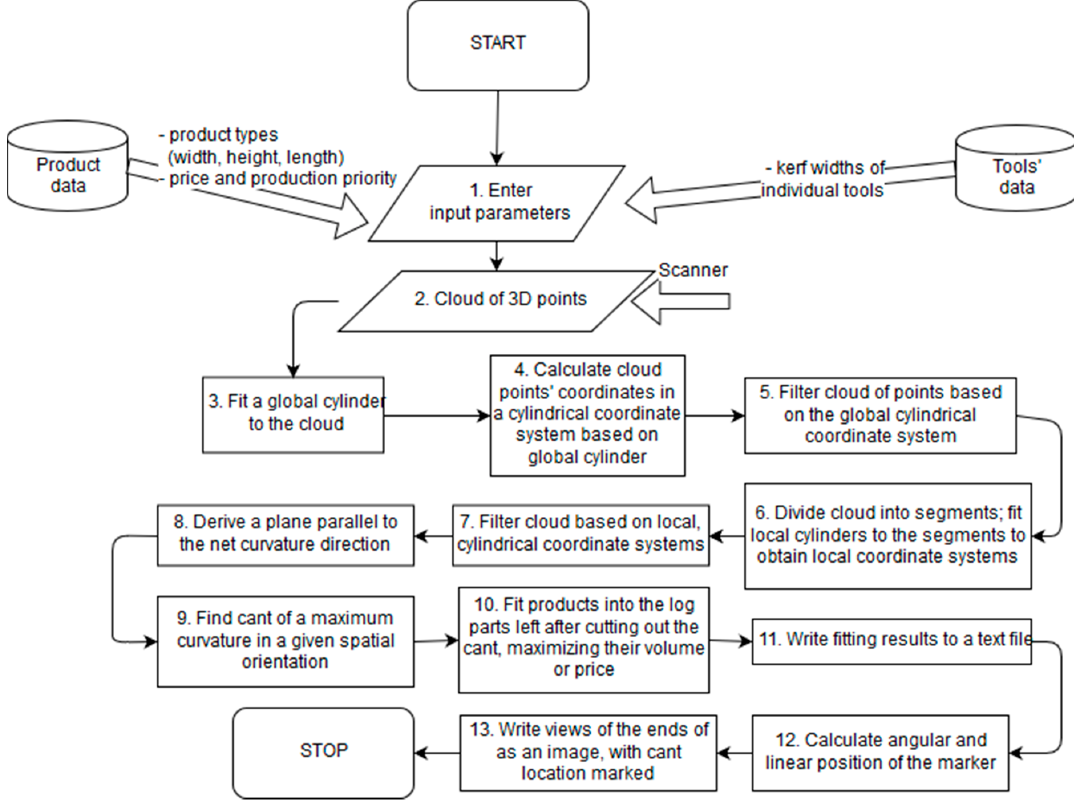
Figure 13. Flowchart of the data processing algorithm.